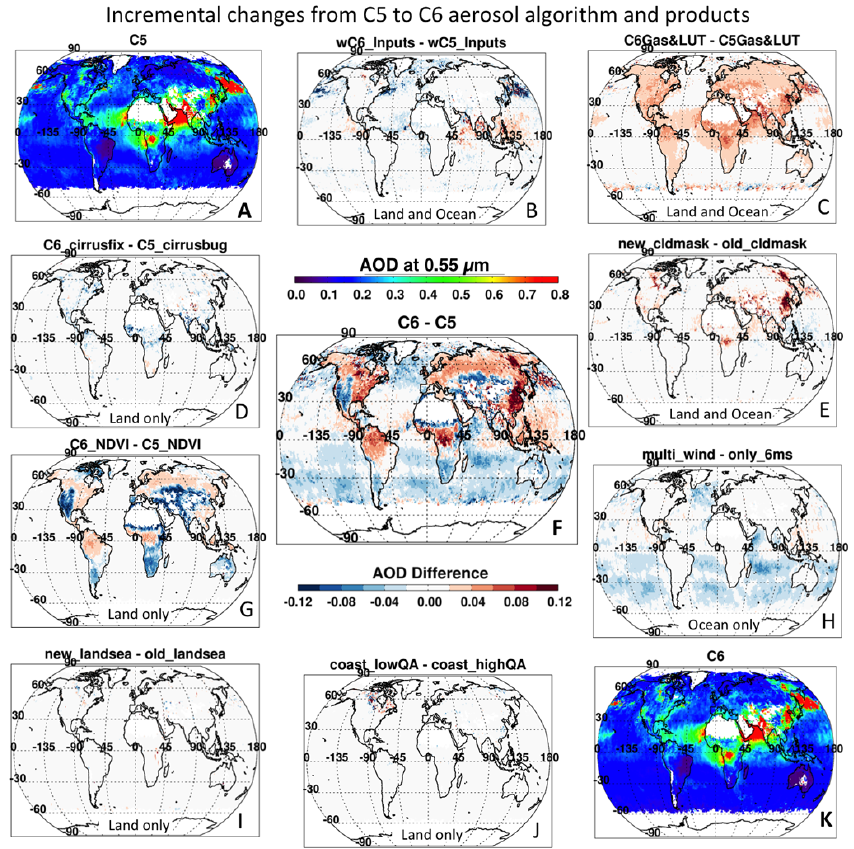
Fig. 2. Global, gridded 1 ◦ × 1 ◦ maps of AOD and AOD differences (new – old) due to major changes to the DT aerosol retrieval algorithm. The example is from July 2008. (a) C5 AOD. (b) Differences due to using new L1B inputs. (c) Differences due to new wavelength and gas absorption coefficients. (d) Differences due to correcting a bug in the cirrus cloud masking. (e) Differences due to modified cloud masking. (g) Differences due to correcting the VIS/SWIR surface relationship to NDVIswir over land. (h) Differences due to including wind speed dependence over ocean. (i) Differences due to treatment of land sea masking. (j) Differences due to treatment of coastal quality flags. (f) Overall differences C6–C5. (k) C6 AOD. The AOD color scale is for (a and k) , whereas the AOD Difference color scale is for all other